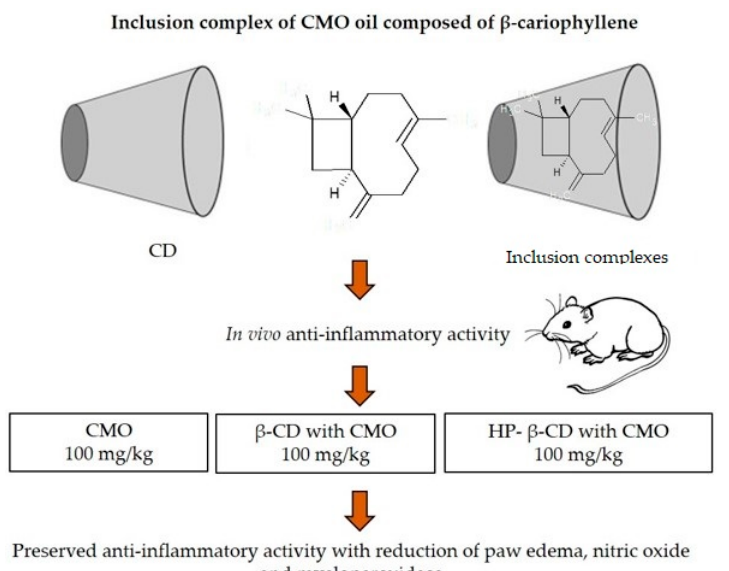
Figure 3. Copaifera multijuga oleoresin, inclusion complex and its main major compound β -caryophyllene and anti-inflammatory activity in vivo [32].